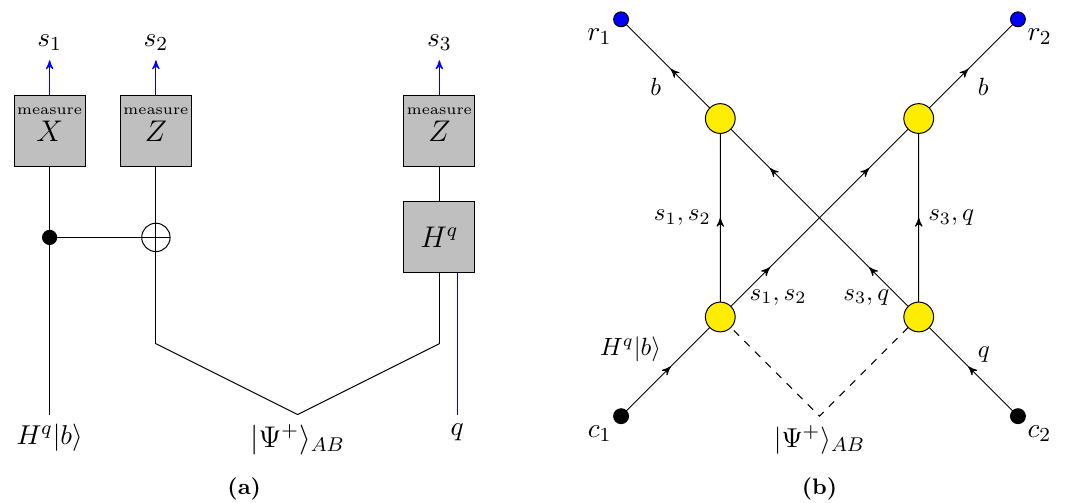
Figure 3. Circuit diagram that completes the B 84 task. Blue lines indicate classical inputs and outputs. The protocol uses one EPR pair, j (cid:9) + i AB = 1 p of the classical measurement outcomes according to ( (cid:0) 1) b = s q